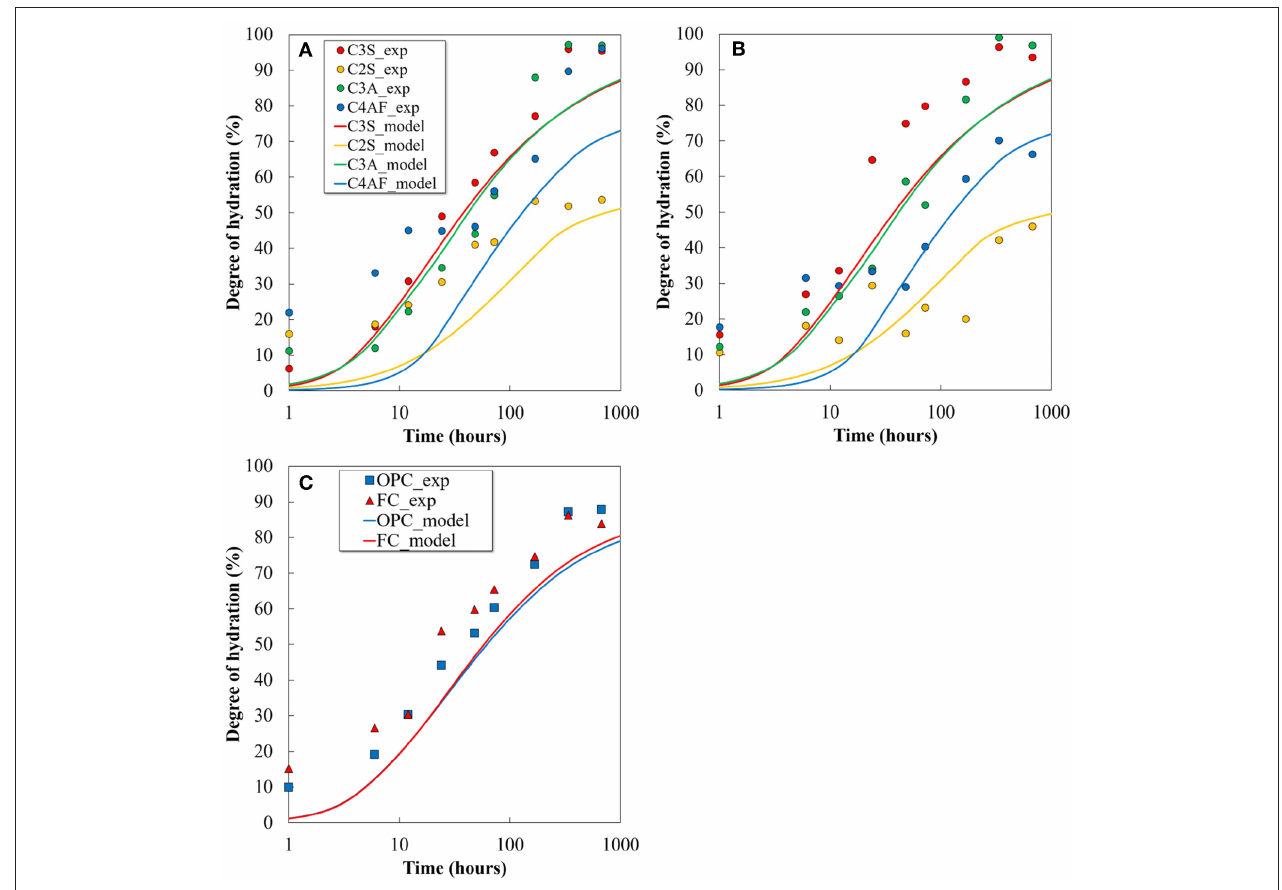
FIGURE 7 | Comparison of calculated hydration degree of each clinker mineral and cements with the quantitative value determined by XRD: (A) OPC, (B) FC, and (C) comparison of total hydration degree.